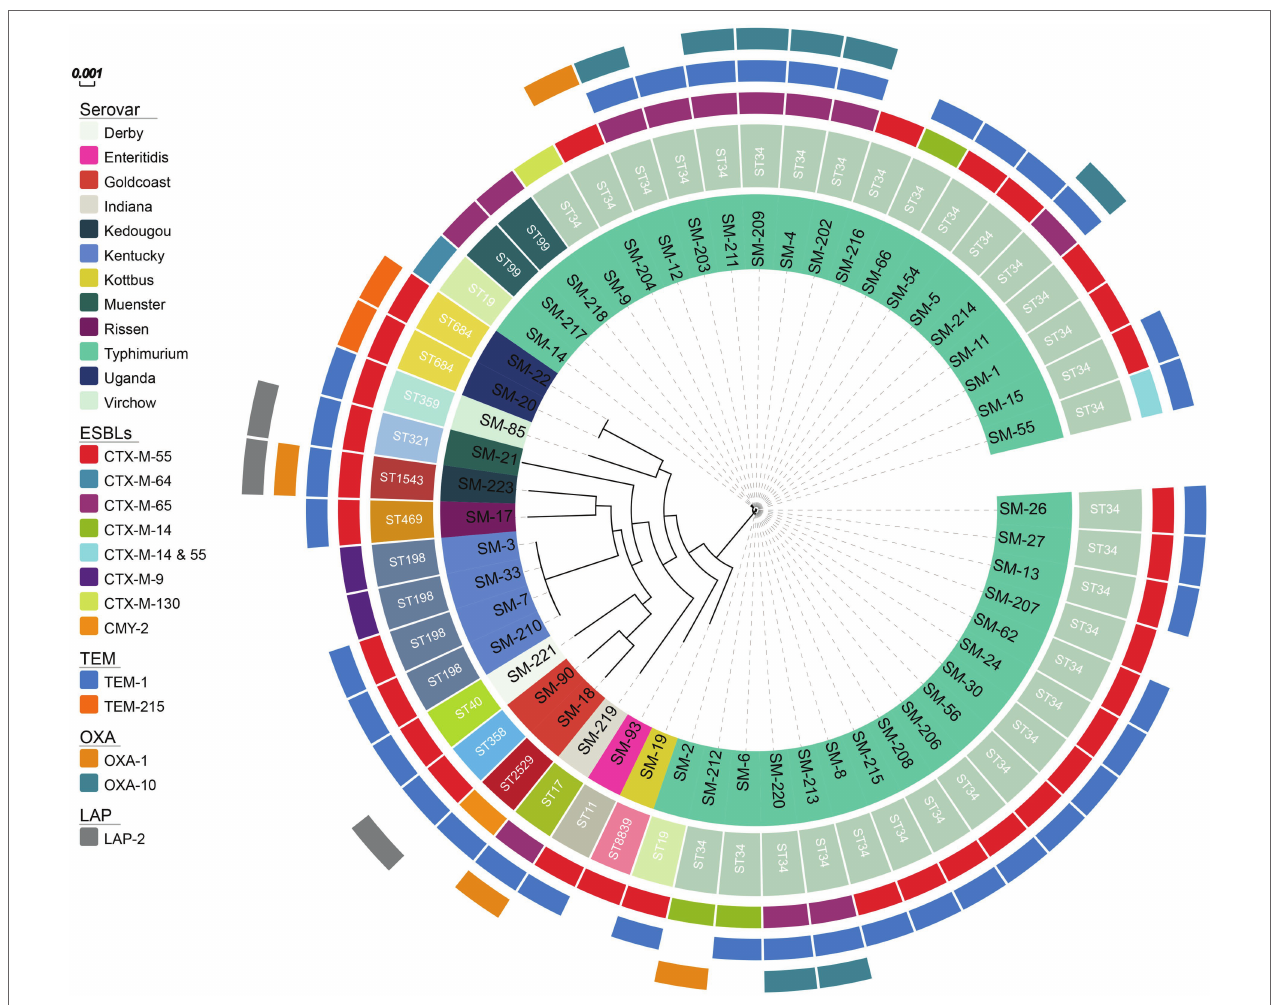
FIGURE 1 | The phylogenetic tree of 53 ceftriaxone-resistant Salmonella from the inside to the outside, each circle represents the ST type, serovar, ESBL genes, bla TEM , bla OXA , bla LAP ,